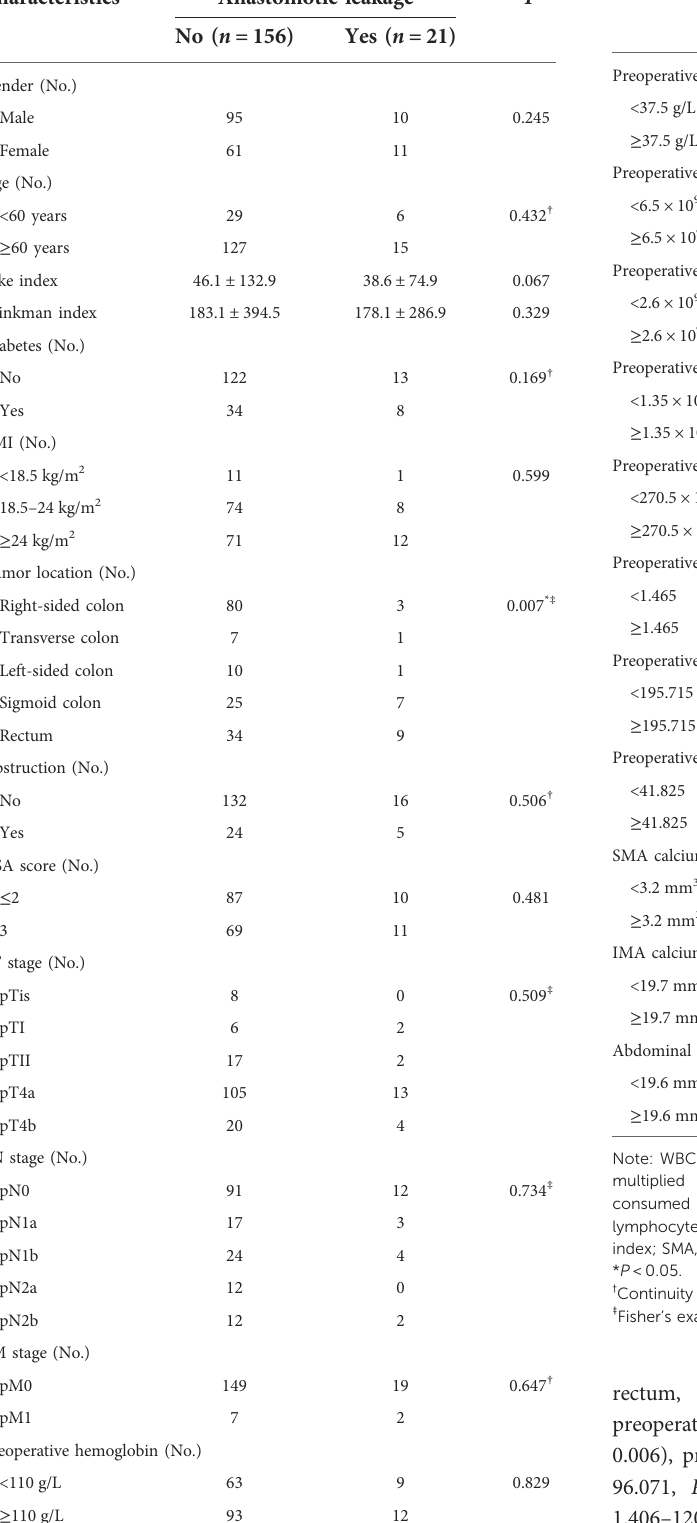
TABLE 3 Univariate analysis of risk factors for anastomotic leakage in training cohort.